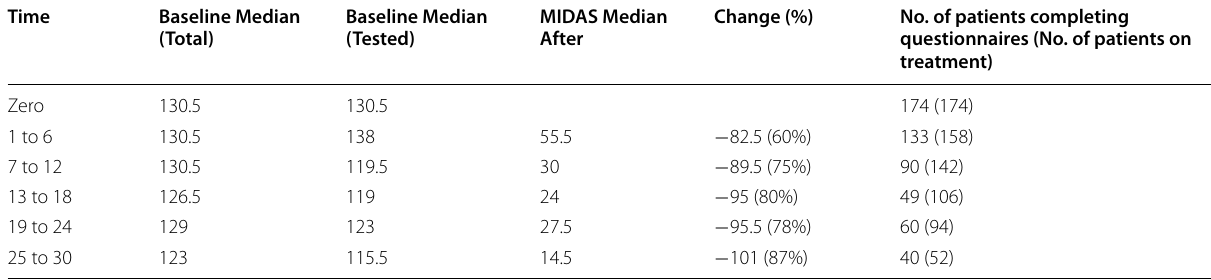
Table 3 Median MIDAS score at baseline and follow up in months. Median difference in MIDAS compared to baseline and percentage change in MIDAS compared to baseline. Proportion of patients contributing to the data